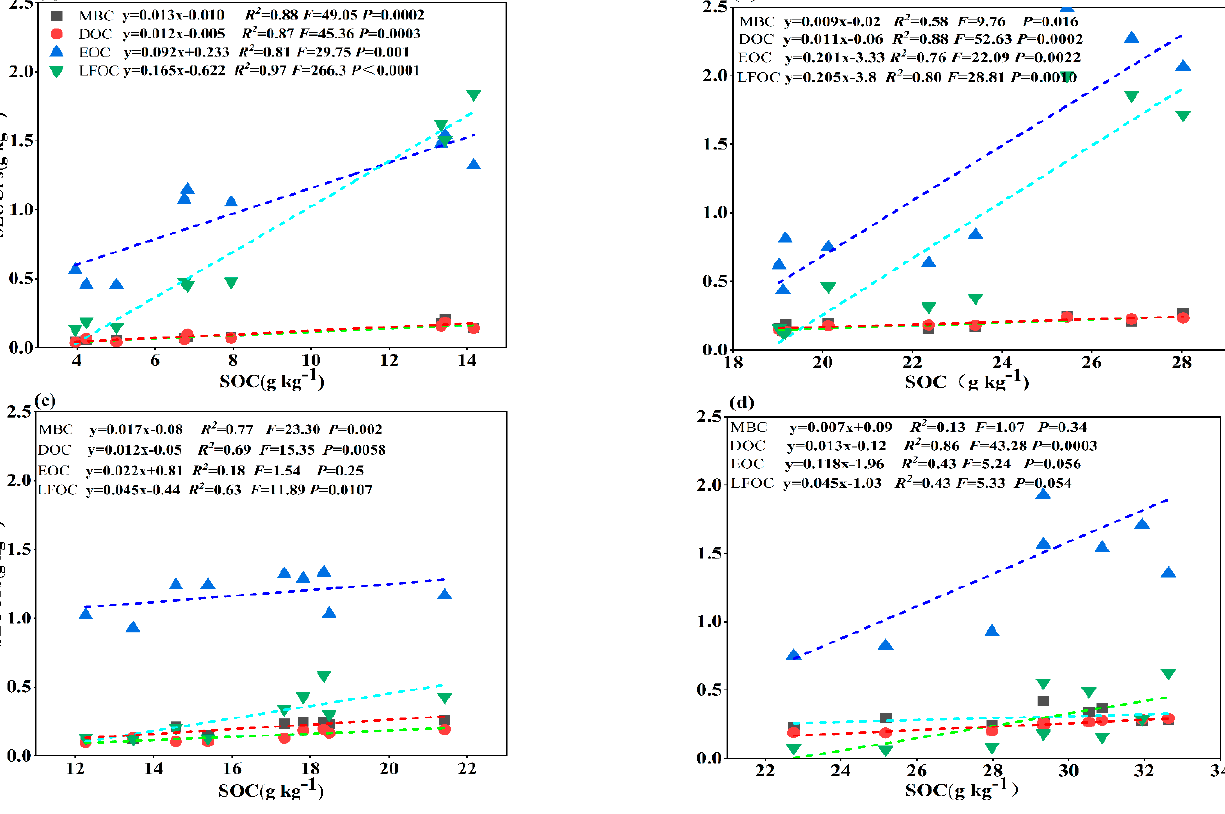
Figure 6. Linear regression of SLOCFs and SOC at different bedrock exposure rates. ( a ) secondary forest; ( b ) light bedrock exposure; ( c ) moderate bedrock exposure; and ( d ) intense bedrock exposure.